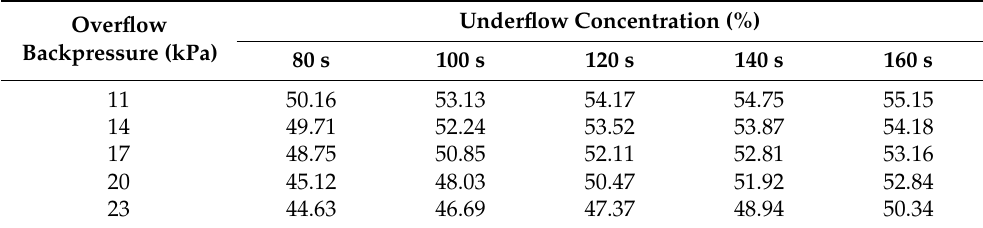
Table 3. Changes in the underflow concentration under different overflow